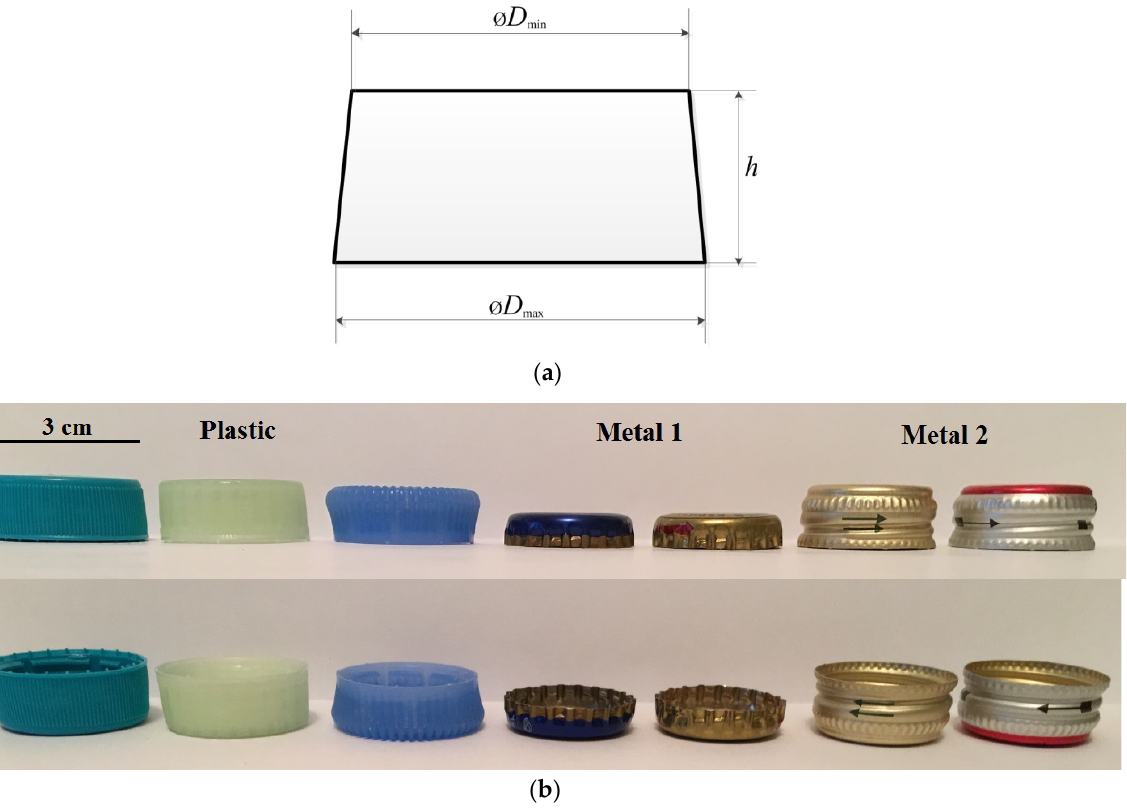
Figure 2. A simplified sketch ( a ) of a side view of a particle, demonstrating the shape and size. Examples of the particles ( b ) used in the study.